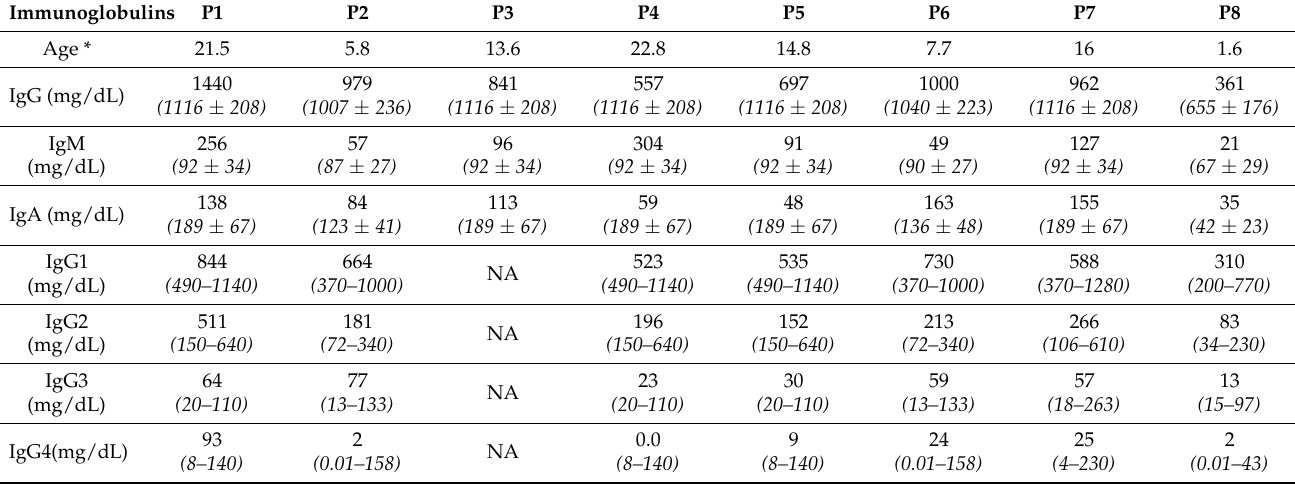
Table 5. Immunoglobulins and their subclasses in the